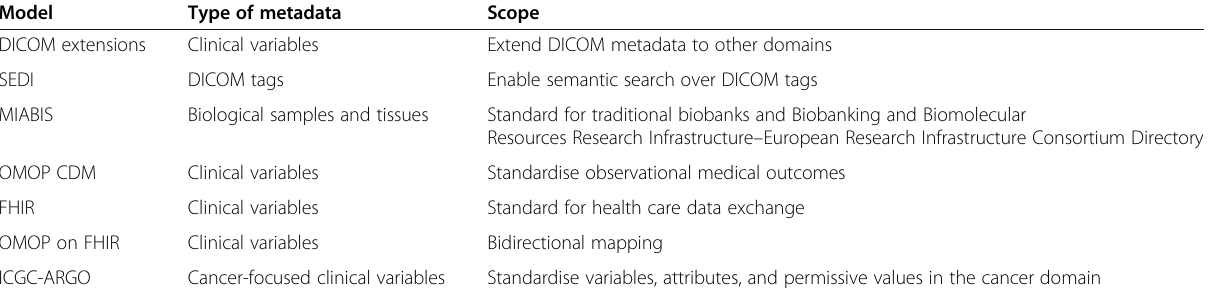
Table 1 Summary of the most relevant metadata models currently available, the type of metadata they represent, and the scope of the